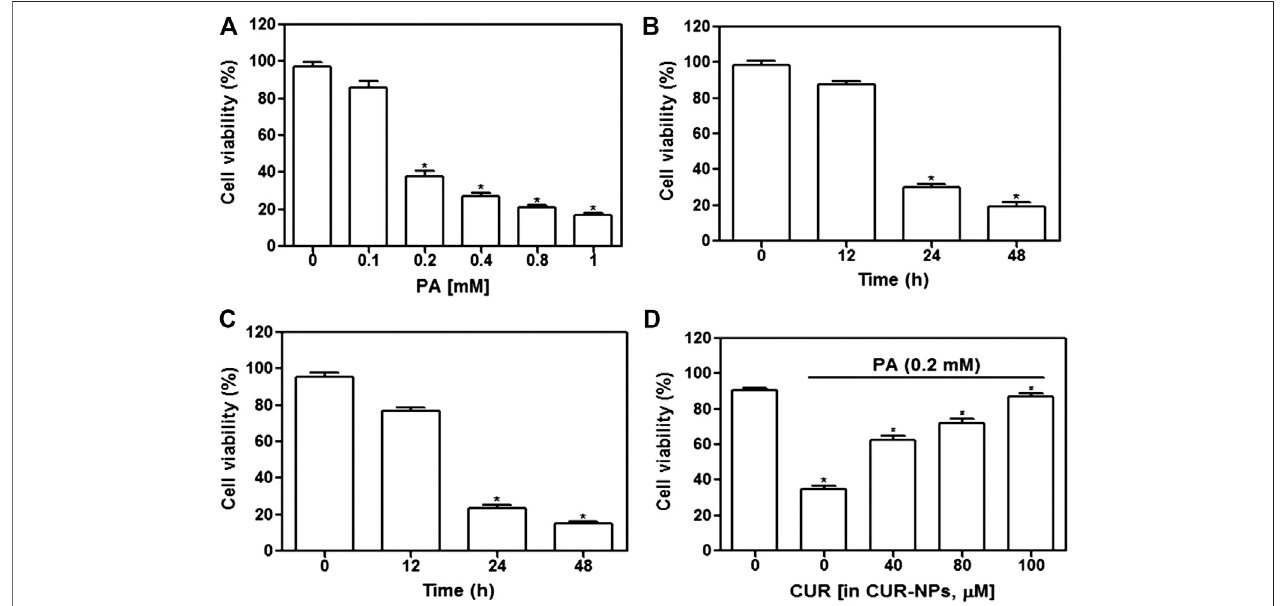
FIGURE 3 | Effect of CUR-NPs on PA-induced cardiomyocyte survival depression (A) Effects of different concentrations of PA on viability of cardiomyocytes. * p < 0.05 vs 0 mM group (B) Changes of viability of cardiomyocytes stimulated with 0.2 mM PA for different time. * p < 0.05 vs 0 h group (C) Changes of viability of cardiomyocytes stimulated with 0.4 mM PA for different time. * p < 0.05 vs 0 h group (D) Effect of CUR-NPs on viability of cardiomyocytes stimulated by PA (incubation concentration was 0.2 mM, incubation time was 24 h). * p < 0.05 vs control group; # p < 0.05 vs PA